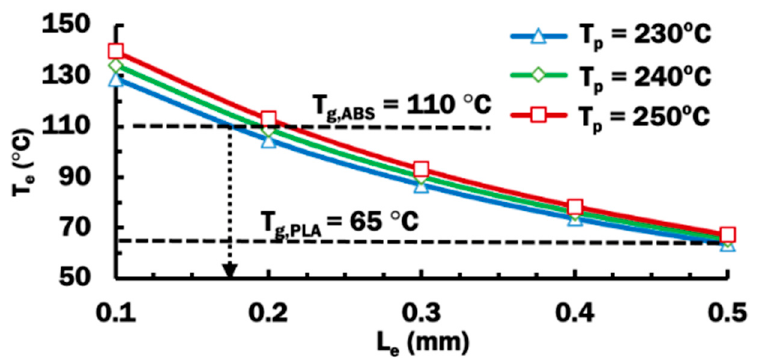
Figure 10. Influence of extruded length of PLA filament on the temperature at end of extruded material, T e , using different printing temperatures.